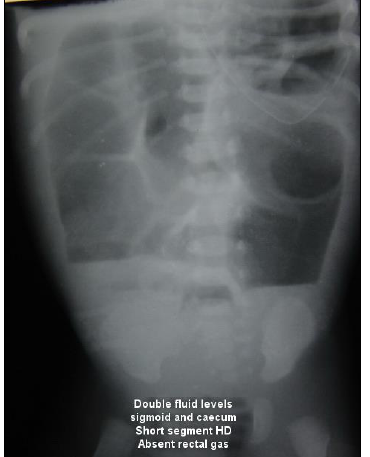
Figure 3: X-ray showing absent gas in the pelvis- aganglionosis of distal colon.